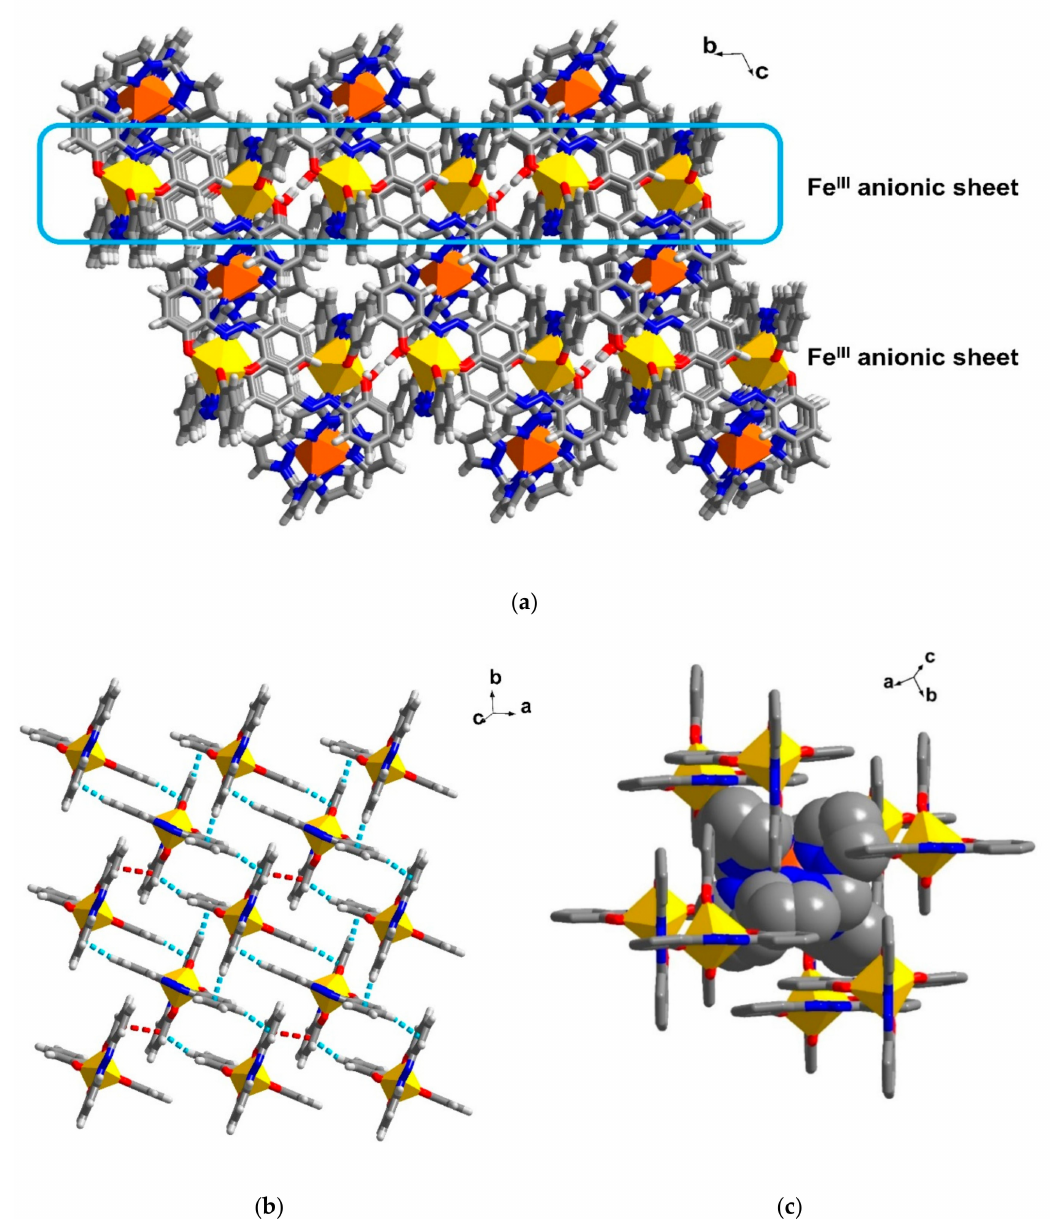
Figure 5. Crystal packing in 4 showing ( a ) the cationic Fe II molecules align in between the anionic Fe III sheet, ( b ) π - π (red broken lines) and C-H ··· π (blue broken lines) interactions connecting [Fe III (azp) 2 ] − moieties into a crossing net and ( c ) space filling model of a [Fe II {(pz) 3 CH} 2 ] 2 + molecule in a pocket of [Fe III (azp) 2 ] − moieties. Yellow and orange polyhedral represent a coordination sphere of Fe III and Fe II ,